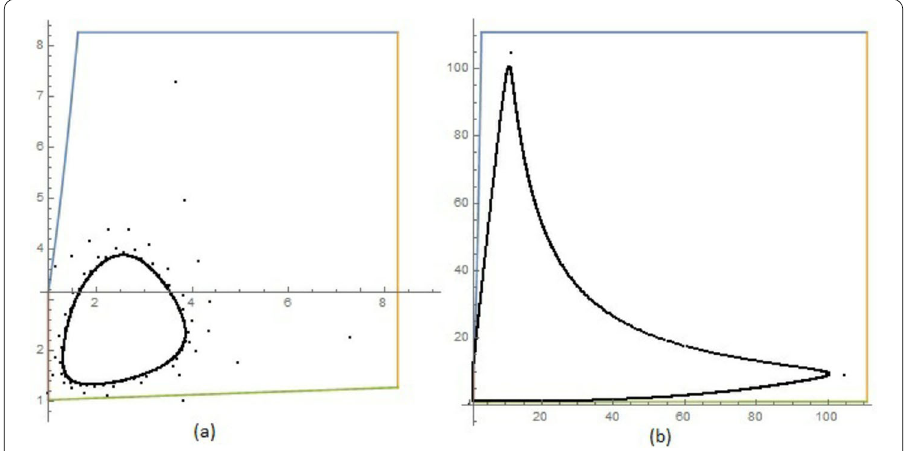
Figure 2 Trajectory of the point (0.1,0.2) and invariant set S t for (a) p = 2.3 and t 0 ( p ) ≈ 8.27071561 (b) p = 10 and